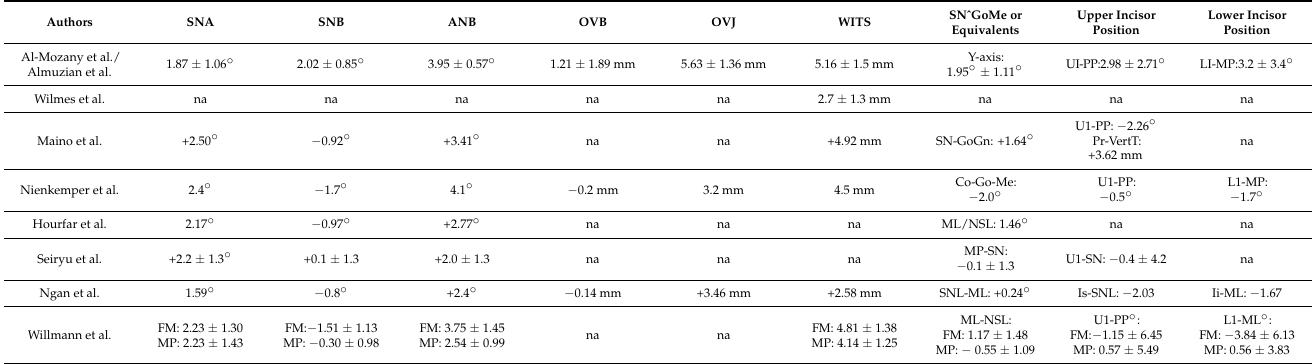
Table 3. Dentoskeletal cephalometric